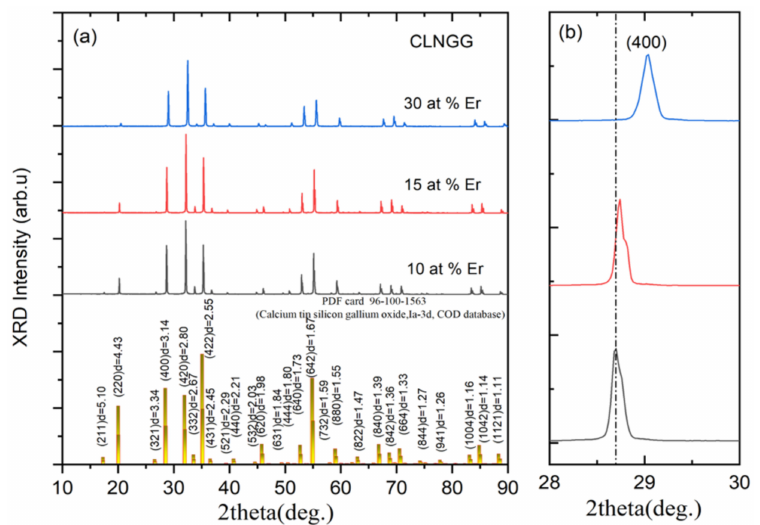
Figure 2. ( a ) Room-temperature X-ray powder diffraction (XRD) pattern of Er:CLNGG crystal and the reference pattern of calcium tin silicon gallium oxide: garnet phase with Ia 3d space group (PDF card #96-210-1676) ( b ) the magnified XRD patterns with the selected diffraction peaks from 28 to 29 ◦ for 10, 15 and 30 at.% Er:CLNGG